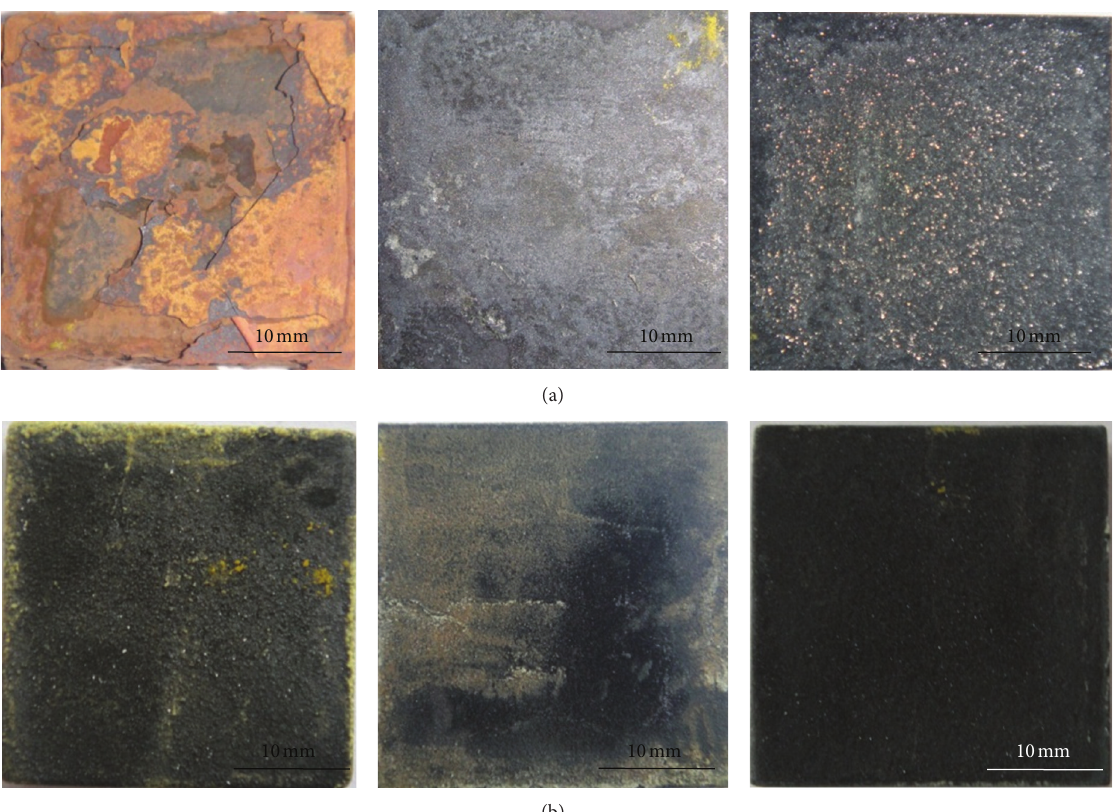
Figure 6: Macrographs of uncoated substrates (top row, in sequence for Ti-31, Superco-605, and MDN-121) and 25% (Cr 3 C 2 -25(Ni20Cr)) + NiCrAlY coating (bottom row, in sequence for Ti-31, Superco-605, and MDN-121) subjected to hot corrosion in Na 2 SO 4 -50%V 2 O 5 environment at 800 ∘ C for 50 cycles.